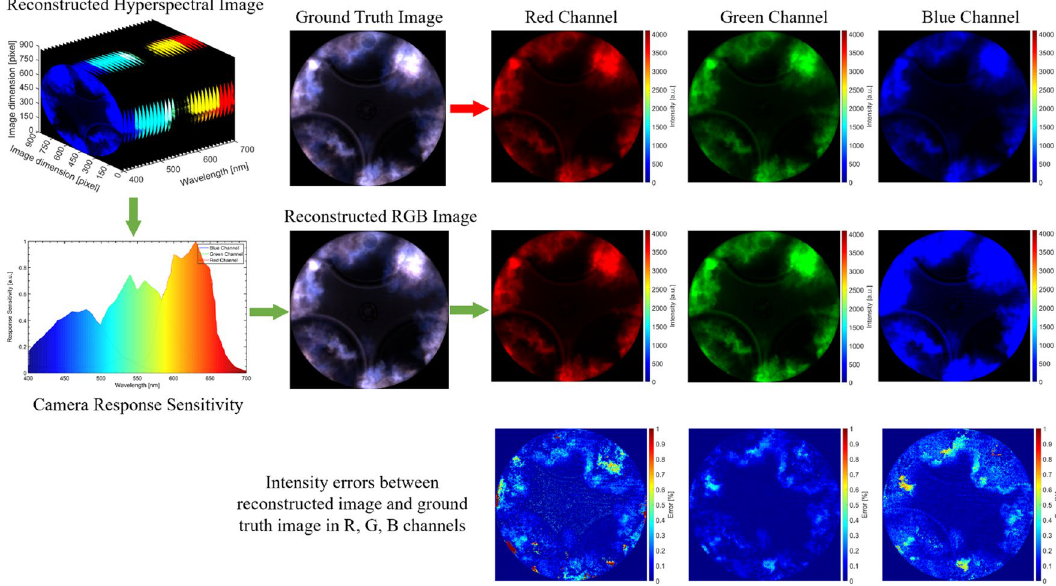
Figure 6. Comparison of the reconstructed RGB image and Raw